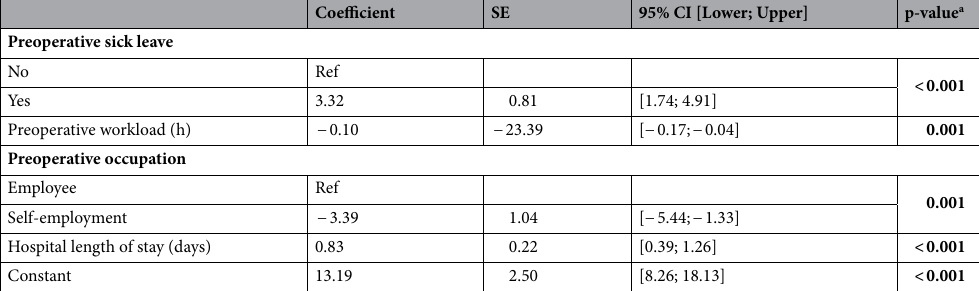
Table 2. Multivariate linear regression analysis assessing the variables influencing the time period to work resumption. Bold values indicates statistical significance at the p < 0.05 level. Excluded variables gender (p = 0.534), age at surgery (p = 0.053), age at questionnaire (p = 0.414). SE standard error, CI confidence interval. a Multivariate linear regression analysis.